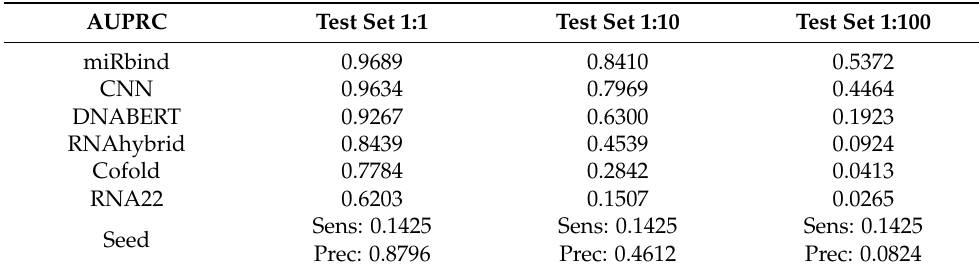
Table 2. The area under the precision-recall curve for the miRBind, CNN, and DNABERT models, and the RNAhybrid, ‘cofold’, RNA22, and ‘seed’ approaches, tested against 1:1, 1:10, and 1:100 left-out test sets. The ‘seed’ method is evaluated based on its sensitivity and precision.